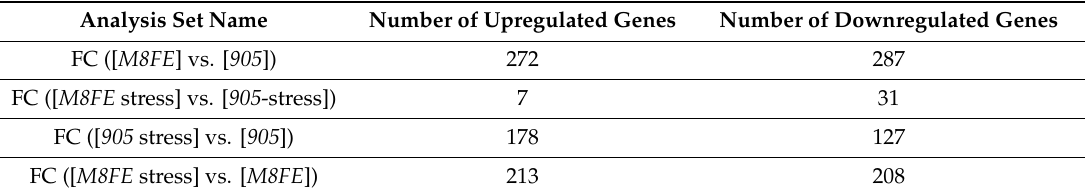
Table 2. Up- and downregulated gene numbers of various combinations of gene expression analysis